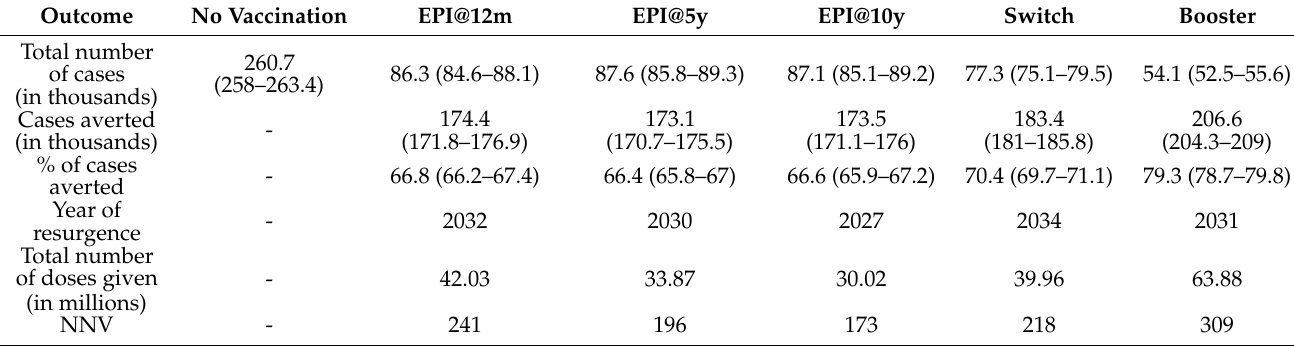
Table A2. Numerical results for the different vaccination scenarios for the time period 2010–2060. Duration of protection is 10 years and vaccine uptake for children routinely immunized over the age of 12 months is assumed to be 80%. Each value presented is the mean and 95% confidence interval is given inside the brackets.